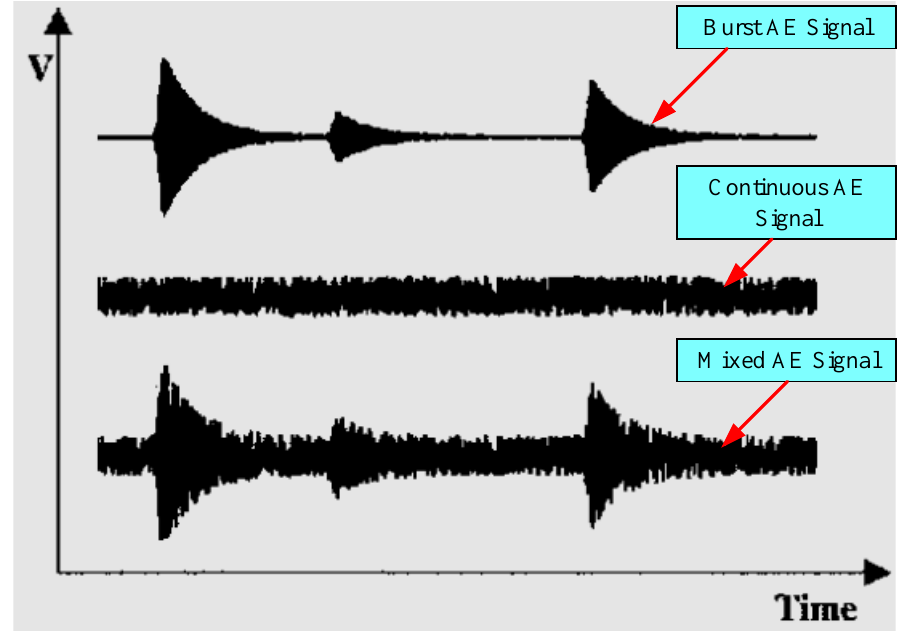
Figure 14. Different types of AE signals recorded from the experiments